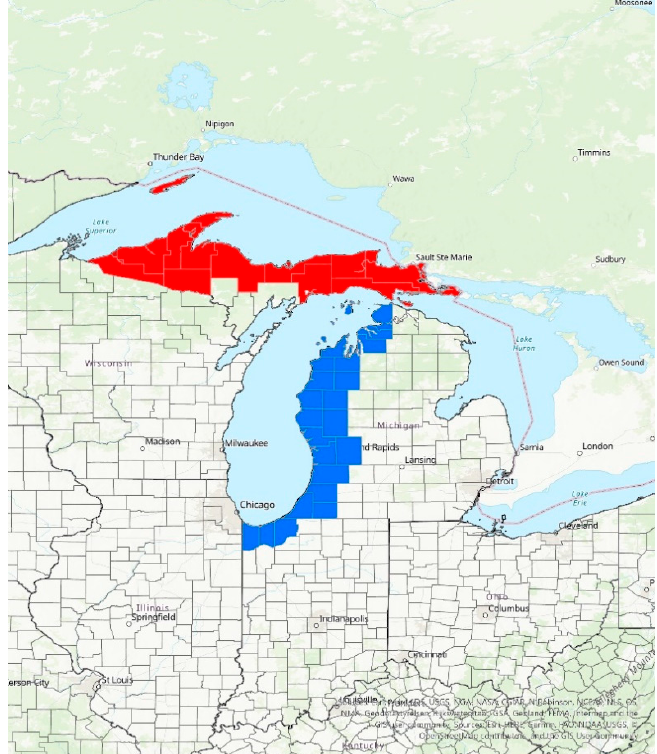
Figure 3. Counties used to identify LES cases from the NOAA Storm Events Database. Counties highlighted in blue were used for identifying Lake Michigan cases and the red counties were used for the Lake Superior cases.